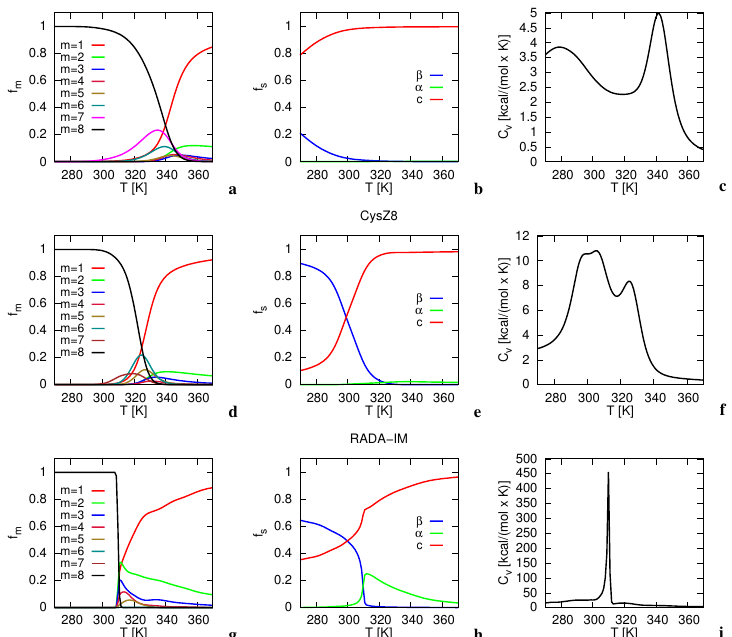
Figure 2. Temperature profiles of the fractions of the oligomer and subsequent multimers ( f m , m = 1, . . . ,8; a , d , g ), fractions of β , α , and statistical-coil structure ( f s , s = α , β ,c; b , e , h ) and heat capacity ( c , e , i ) of CysZ5 ( a – c ) CysZ8 ( d – f ) and RADA-IM ( g – i ) obtained from MREMD simulations of eight peptide chains. The peptide names are shown above the middle graphs. The graphs were drawn with gnuplot